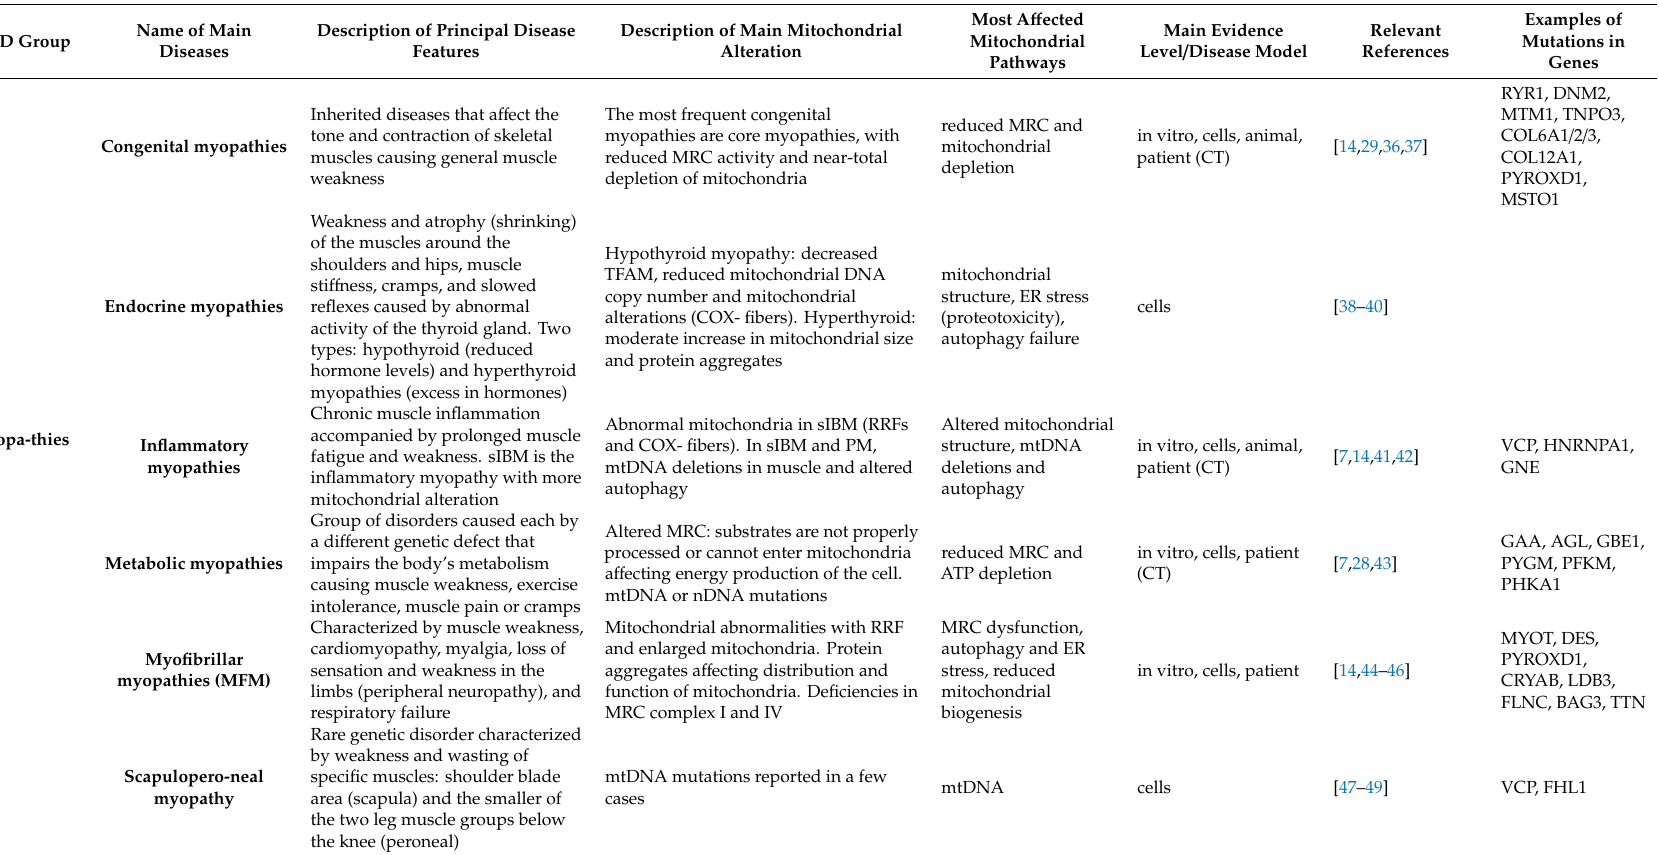
Table 2. Examples of studies reporting altered mitochondrial functions in myopathies other than